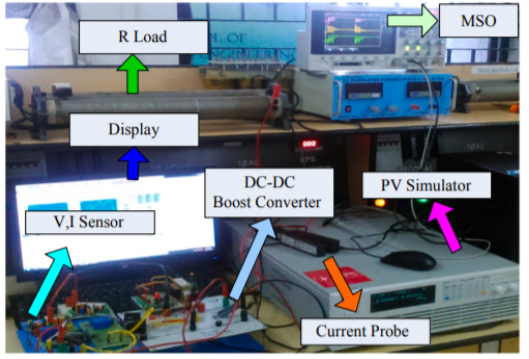
Figure 18. Experimental setup of DC–DC boost converter developed for SHO methods. Performance summary of all defined pattern results are tabulated in below Table 2. Table 2. Comparative analysis of P and O, PSO, and SHO